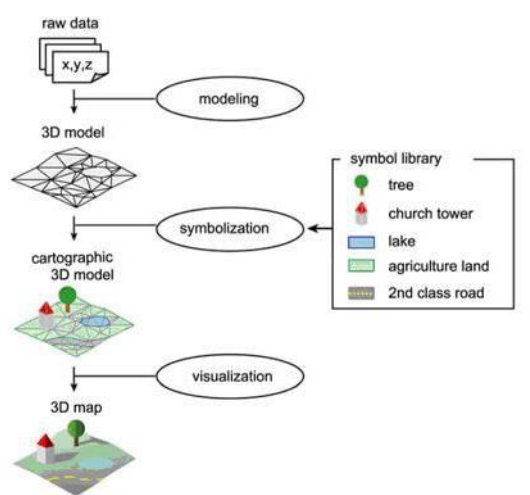
Fig. 2. Schematic process of creating 3D maps (Häberling et al., 2008)